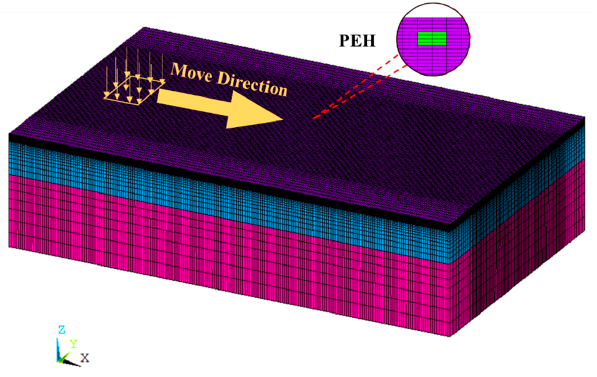
Figure 4. Full scale pavement model with ANSYS.